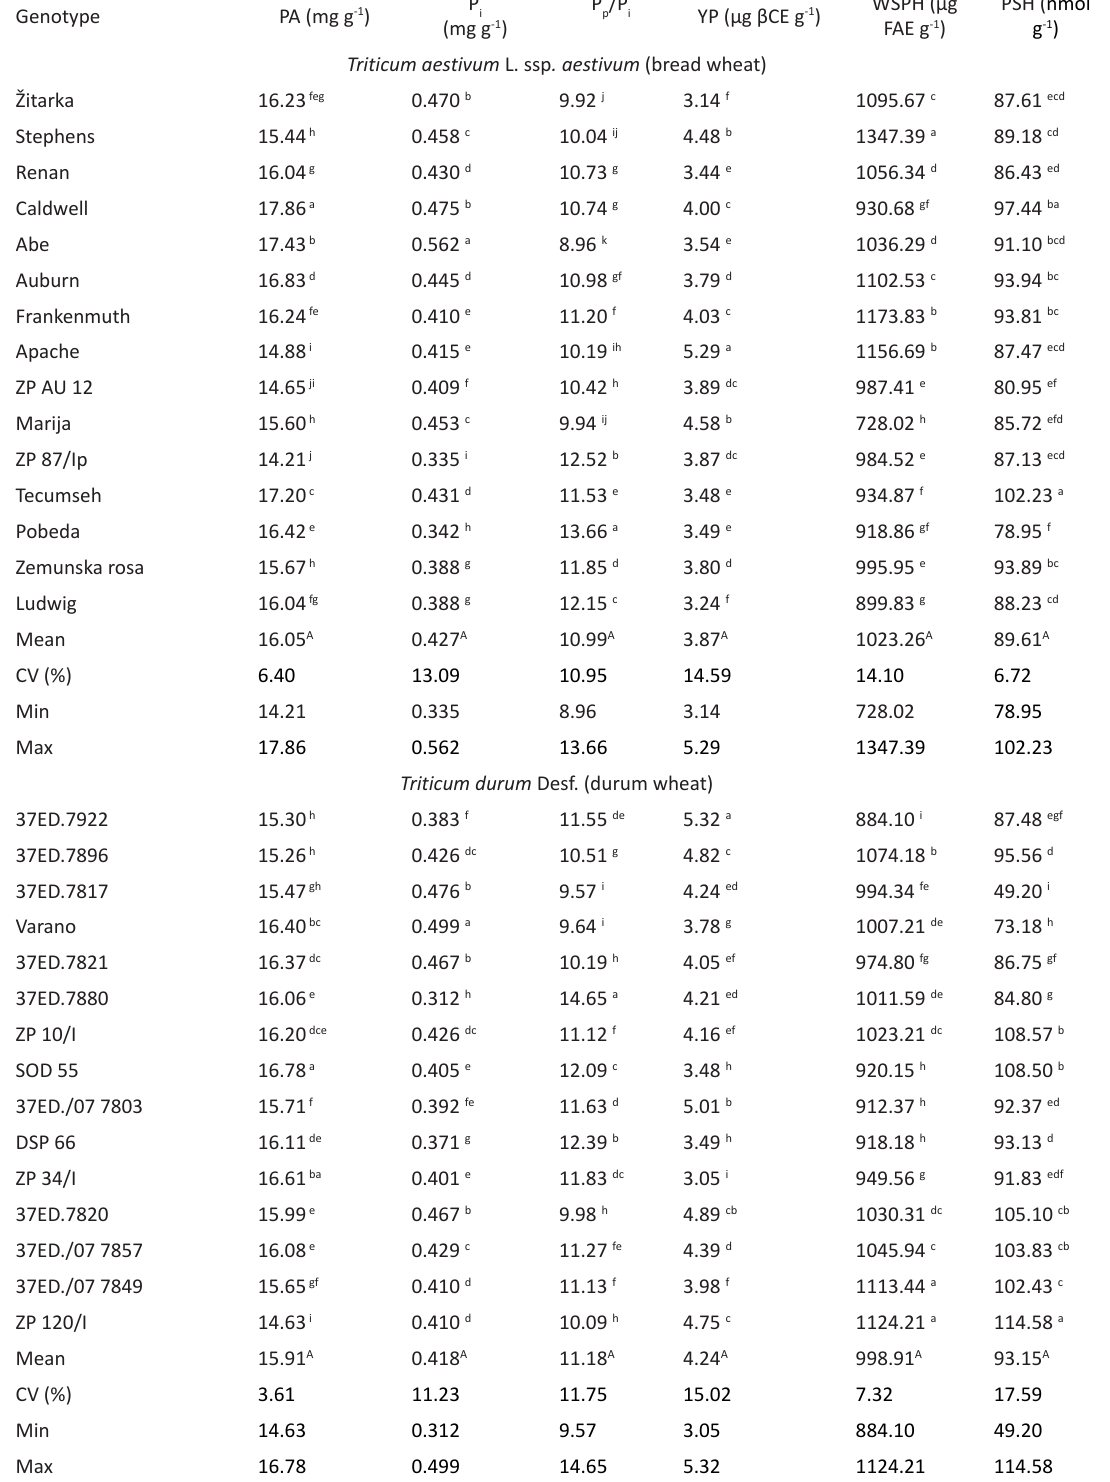
Table 1. Phytic acid, inorganic phosphorus and antioxidants of bread and durum wheat genotypes represented as mean values across six environments